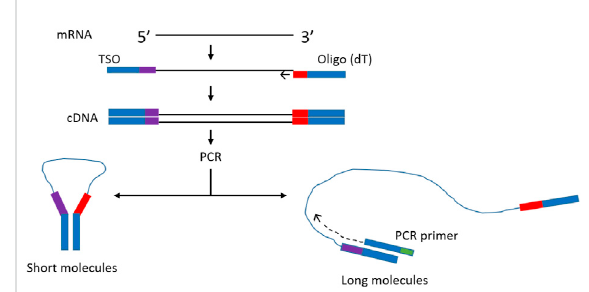
FIGURE 1 Schematic illustration of the Panhandle structure formation. During cDNA synthesis, we incorporate inverted terminal repeats in the oligo (dT) primer and template switching oligo (TSO) as shown with blue bars (green shaded region in Table 1). A single primer is used in PCR with complementary regions to the ITR present at both 5 ′ and 3 ′ ends of cDNA. Short cDNA fragments largely fail to denature preventing primers from binding. Long fragmentsdenatureallowingprimerstobindasdetailed by(Shagin et al., 1999). Adapted form (Shagin et al.,